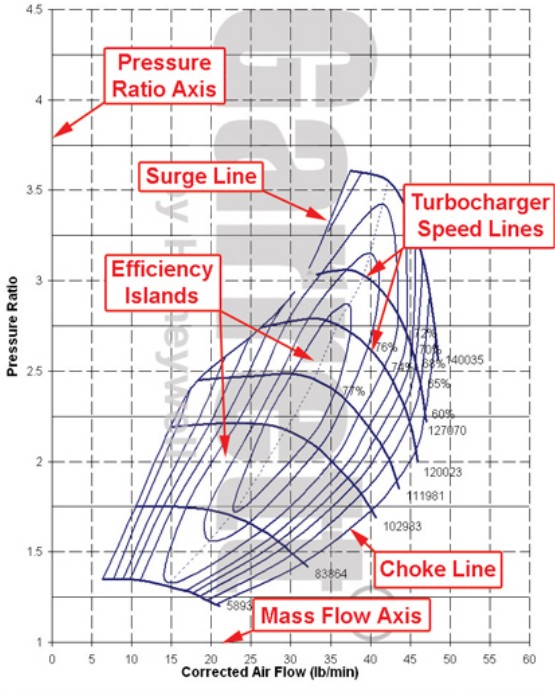
Figure 3. Typical Garrett ® compressor